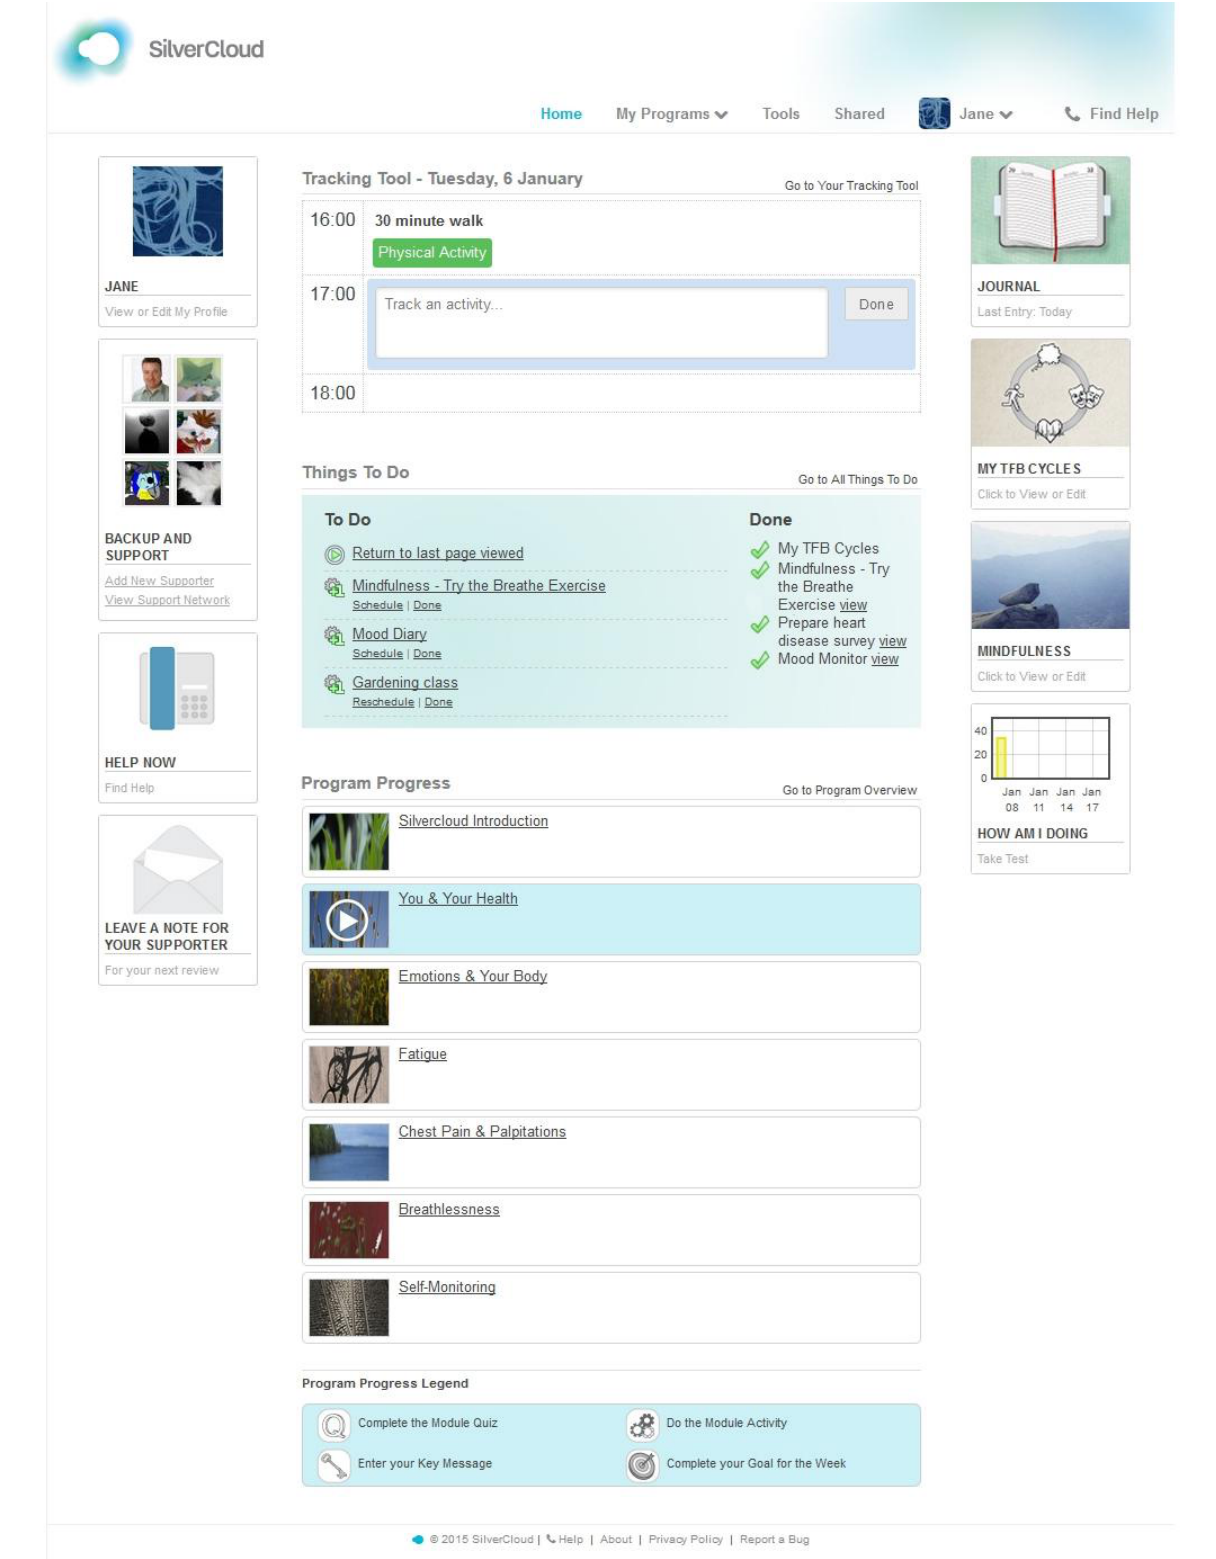
Figure 2. Screenshot of Space from Heart Disease home